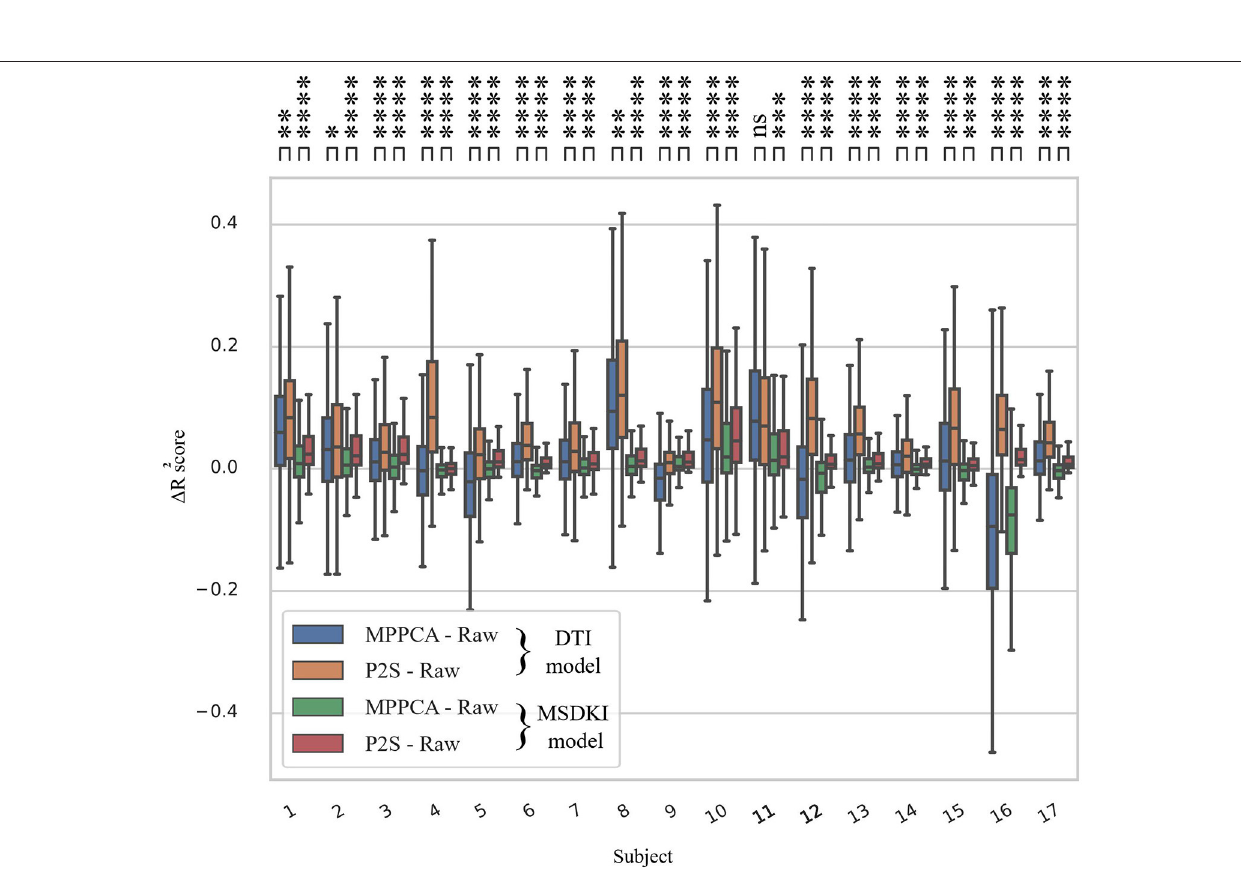
FIGURE 7 | Effects of Patch2Self denoising on noise at different diffusion weightings. (A) Average signal-to-noise ratio computed on b = 0 images, (B) b = 700, and (C) b = 2,100 s/mm 2 increases in all the cohort, across C1–C4 vertebral levels under analysis, when including denoising with Patch2Self algorithm in the processing pipeline.